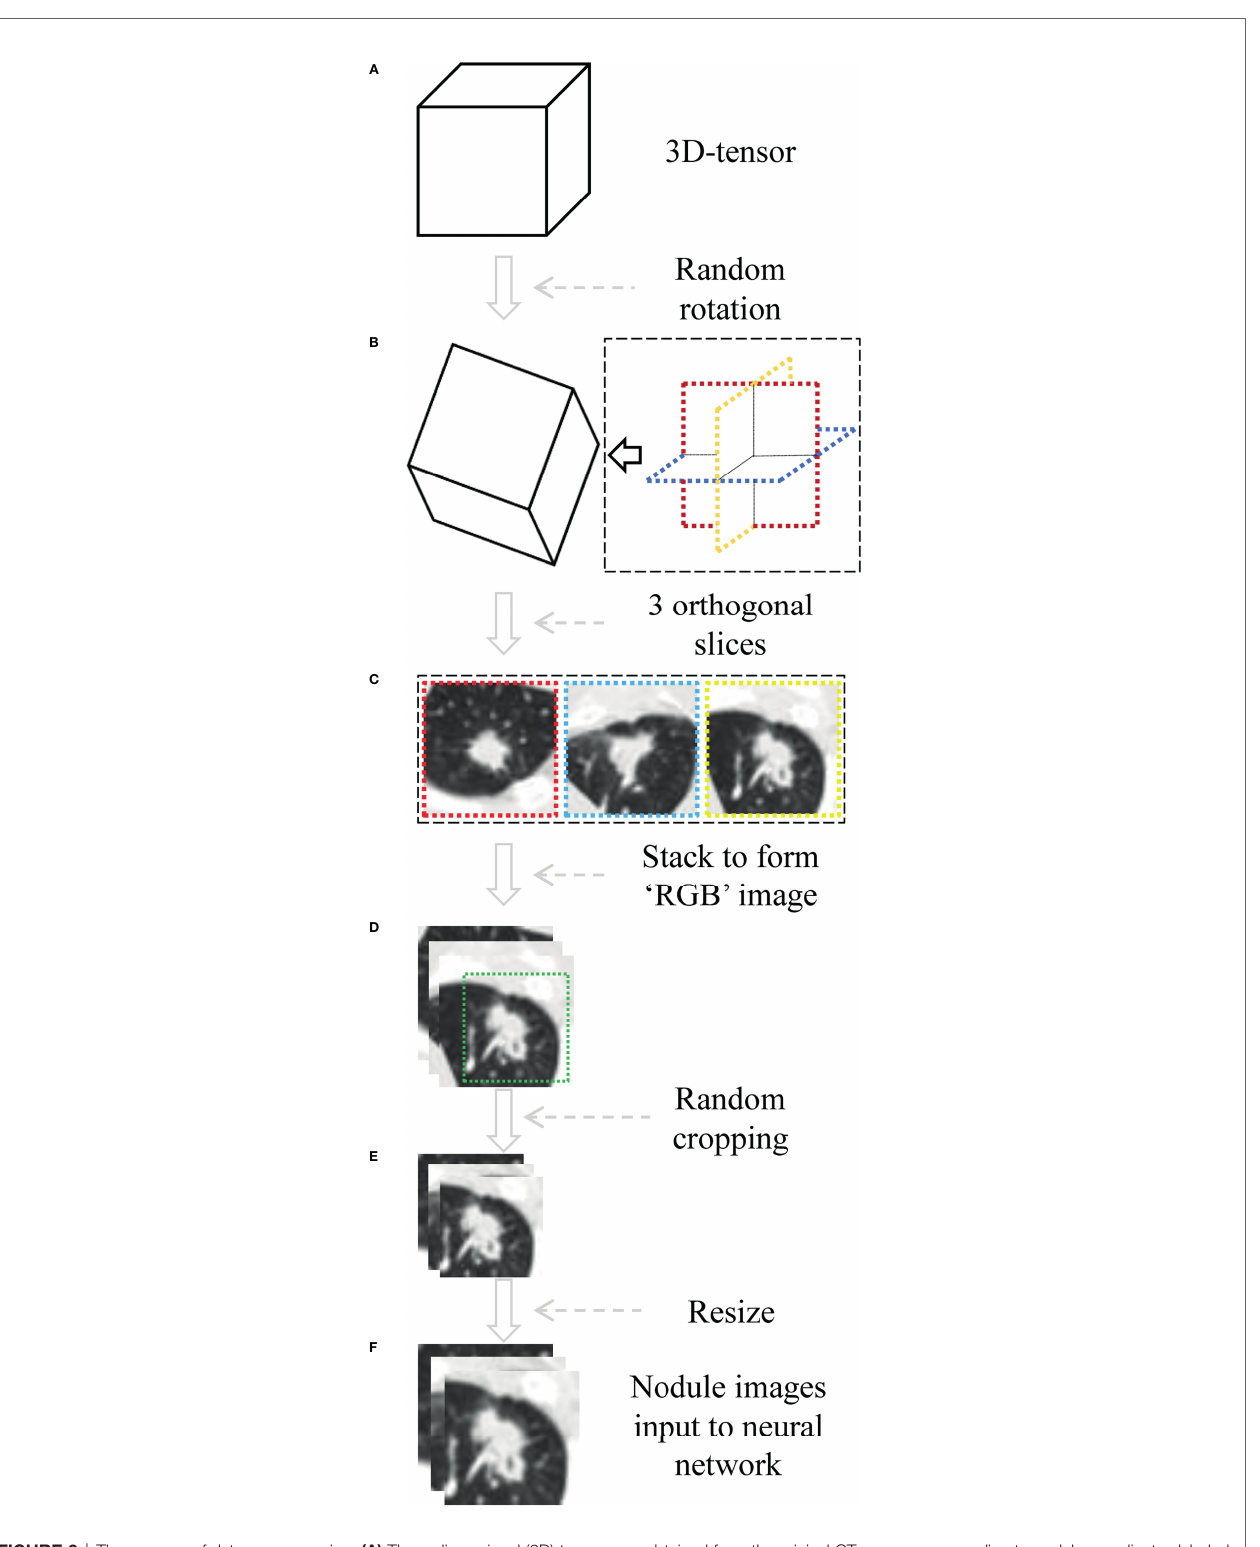
FIGURE 3 | The process of data preprocessing. (A) Three-dimensional (3D) tensor was obtained from the original CT sequence according to nodule coordinates labeled by radiologist. (B) The tensor is rotated at arbitrary angle around its center point. (C, D) Three orthogonal slices spanning center point were extracted and stacked to form a pseudo-RGB map (3×128×128 tensor). (E) Random cropping with 3×104×104 subregion. (F) Nodule images were resized to voxels of